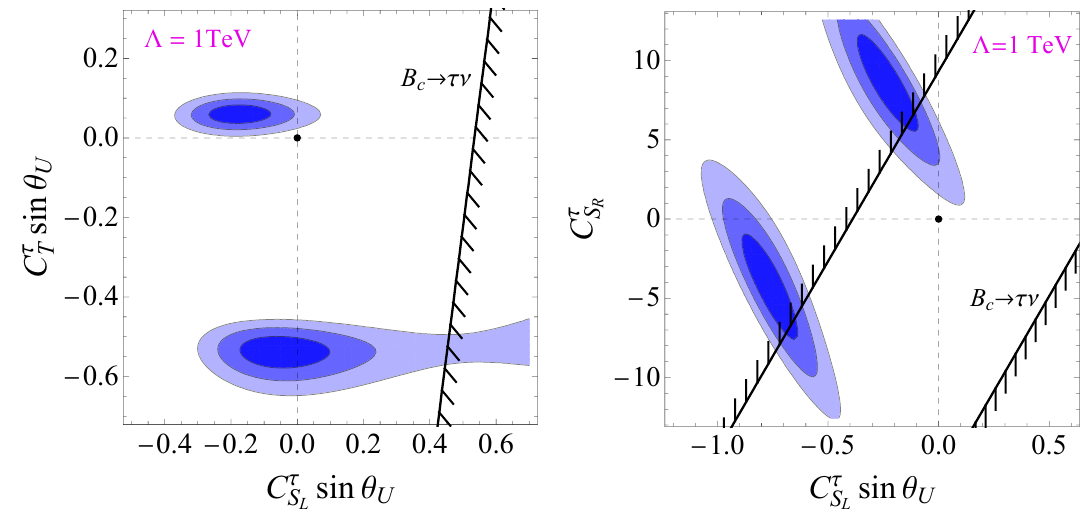
sin (cid:18) U vs. C (cid:28) sin (cid:18) U (left panel), and S L T 1 TeV down to (cid:22) = m b , (cid:25) g P , as j j